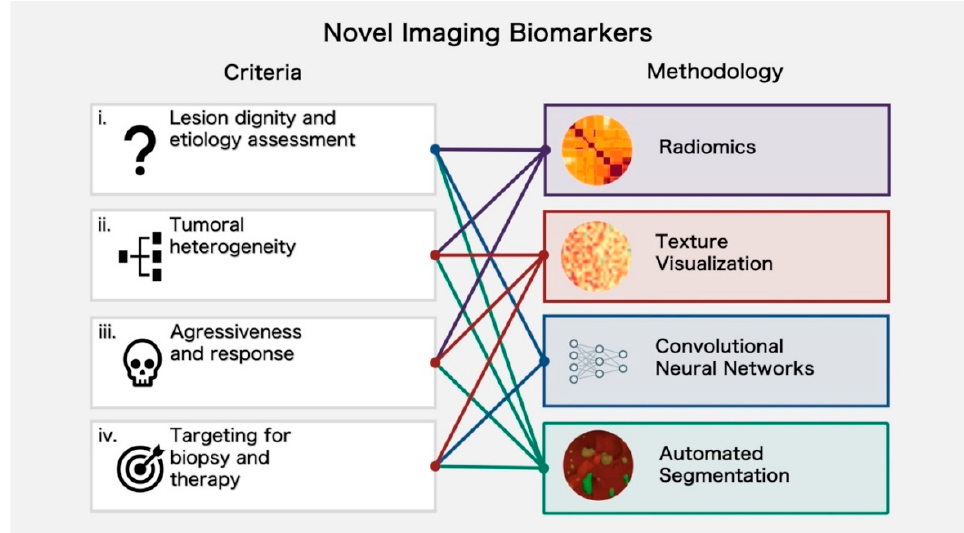
Figure 4 . Criteria and methodology for novel imaging biomarkers. To solve various challenges, different methodologies can be used. This figure shows ideally applicable methods for (i) lesion dignity and etiology assessment, (ii) tumoral heterogeneity, (iii) aggressiveness and response, and (iv) targeting for biopsy and therapy.